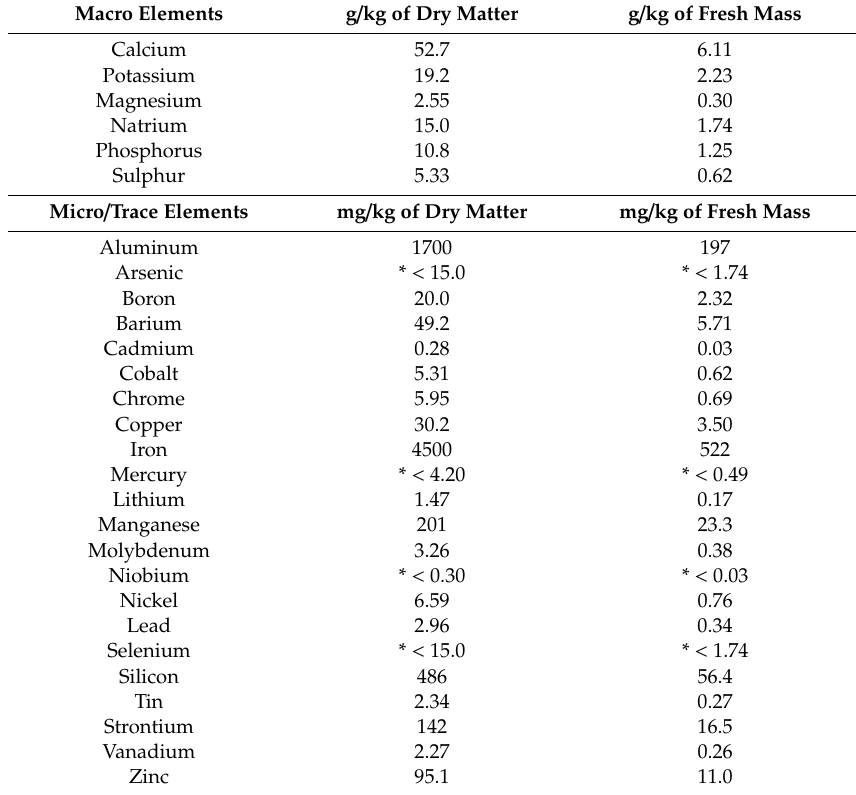
Table 2. Macro-, and Micro / Trace Elements of the inoculum used in this work, which was a digestate of a dry-AD of municipal sorted food